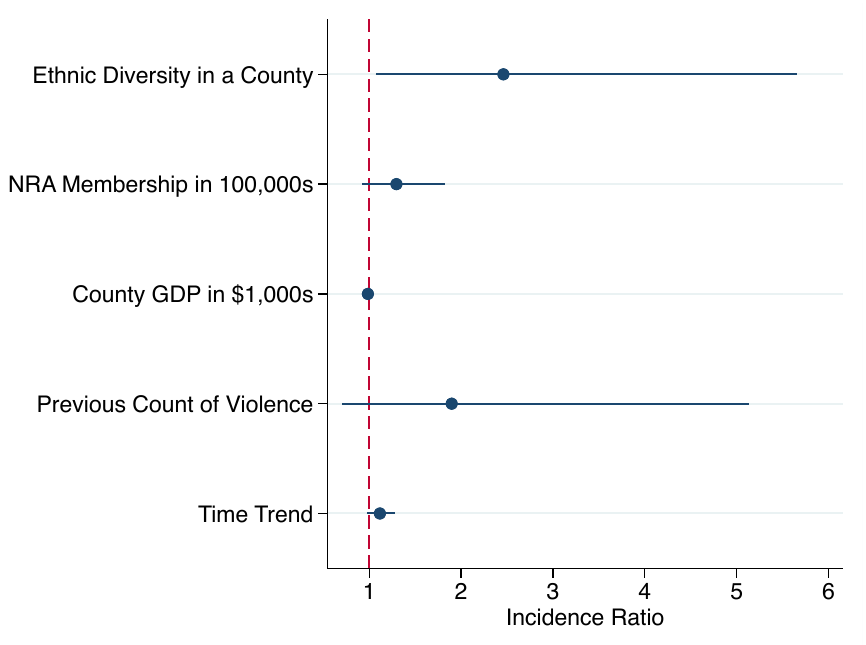
Figure 4: Effects on the counts of right-wing violence in U.S. counties, 2000 through 2018 (estimates from Table